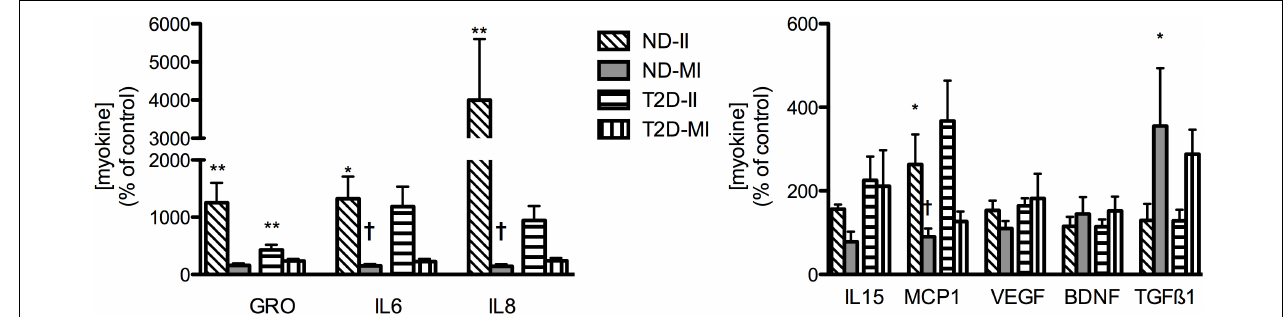
FIGURE 6 | Regulation of myokine secretion by treatment with II or MI. Results presented as a percentage of the matched control (no addition) CM from MT from the same individual, Ave + SEM. The numbers of individual sets of MT evaluated (in duplicate) for each factor are given in the order ND-II/ND-MI/T2D-II/T2D-MI): GRO (11/12/10/12), IL6 (12/12/12/13), IL8 (11/12/12/15), IL15 (5/5/5/5/), MCP1 (6/6/7/7), VEGF (8/8/4/4/), BDNF (4/4/5/5), TGF β 1 (3/3/5/5). * p < 0.05 vs. matched control, ** p < 0.01 vs. matched control, † p < 0.05 vs. matched response to II in MT from the same